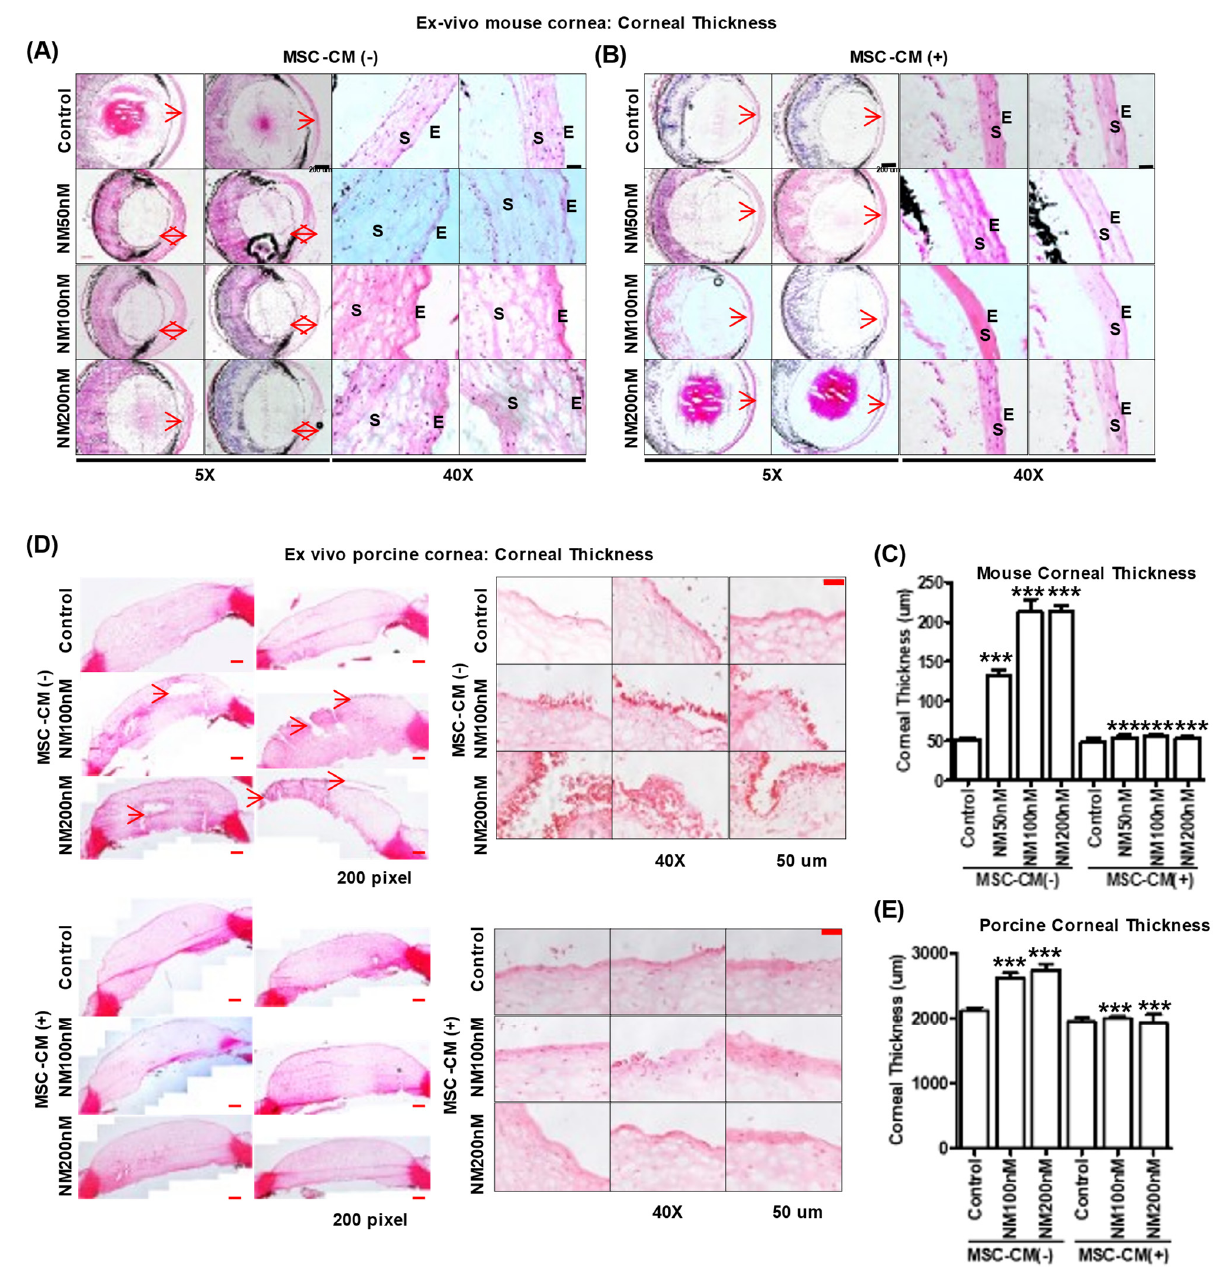
Figure 6. MSC-CM reverses NM-induced corneal epithelial damage in ex vivo mouse eye culture model. ( A , B ) Ex vivo mouse eye culture model: Representative images of H&E staining showing histology of mouse corneas after various doses of NM (50, 100, and 200 nM) in KSFM media for 2 h and washing twice with 1 × PBS. After washing, NM-exposed mouse eyes were replaced with ( B ) or without ( A ) MSC-CM for 2 days and imaged using 5 × and 40 × magnification microscope. S: Stroma, E: Epithelium. ( C ) Graphs showing corneal thickness on mouse cornea area from Figure 6A,B. *** p < 0.001 vs. untreated control or NM treated group (MSC-CM-). ( D ) Ex vivo porcine eye culture model: porcine eyes were cultured in various doses of NM (50, 100, and 200 nM) in KSFM media 2 h and washed two times with 1X PBS. After washing, NM-exposed porcine eyes were replaced with or without MSC-CM for 3 days and imaged using 40 × magnification microscope. ( E ) Porcine corneal thickness was measured from Figure 6D. *** p < 0.001 vs. untreated control or NM treated group